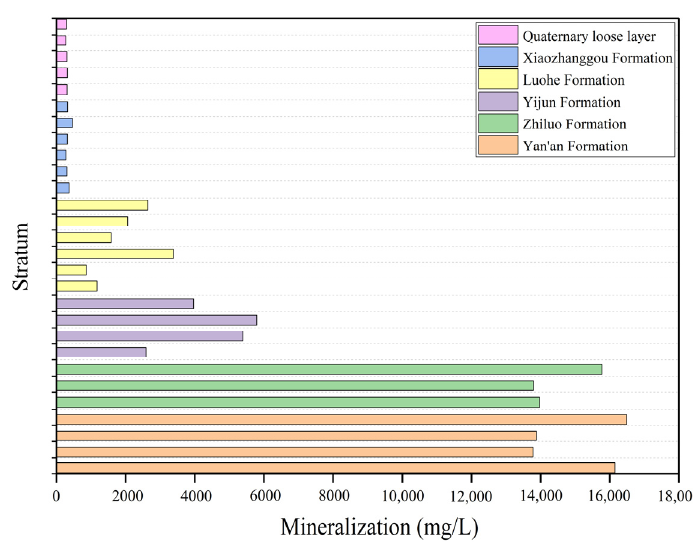
Figure 6. Mineralization degree of groundwater.